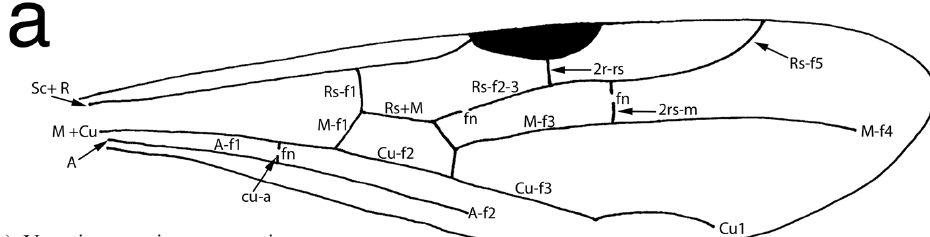
Fig 15a-e . Forewing venation. a) Venation naming convention follows recent work by Bolton (in prep). Upper figure indicates the maximum venation seen in a dolichoderine and includes all of the venation terms employed in this study; Sc+R= subcostal + radial; M+Cu= medial + cubital; A= anal; fn= fenestra in vein. b) Ktunaxia jucunda (USNM# 609585); c) Protazteca eocenica (USNM# 609590); d) Formica annosa (USNM# 609591); e) Lasius glom (USNM#